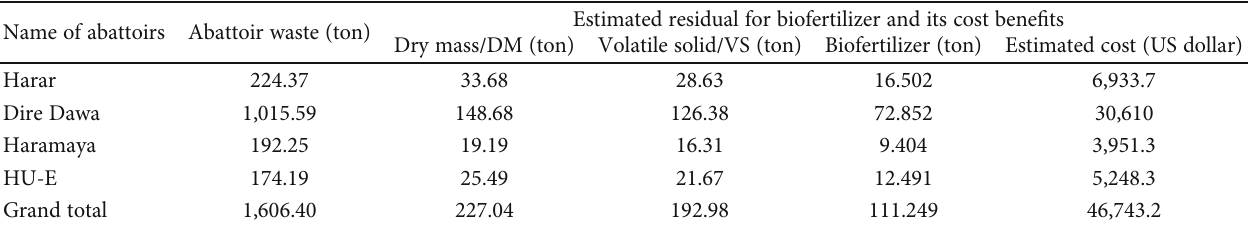
Table 6: Estimation of biofertilizer production from abattoir waste of the selected abattoirs, 2019. Name of abattoirs Abattoir waste (ton)